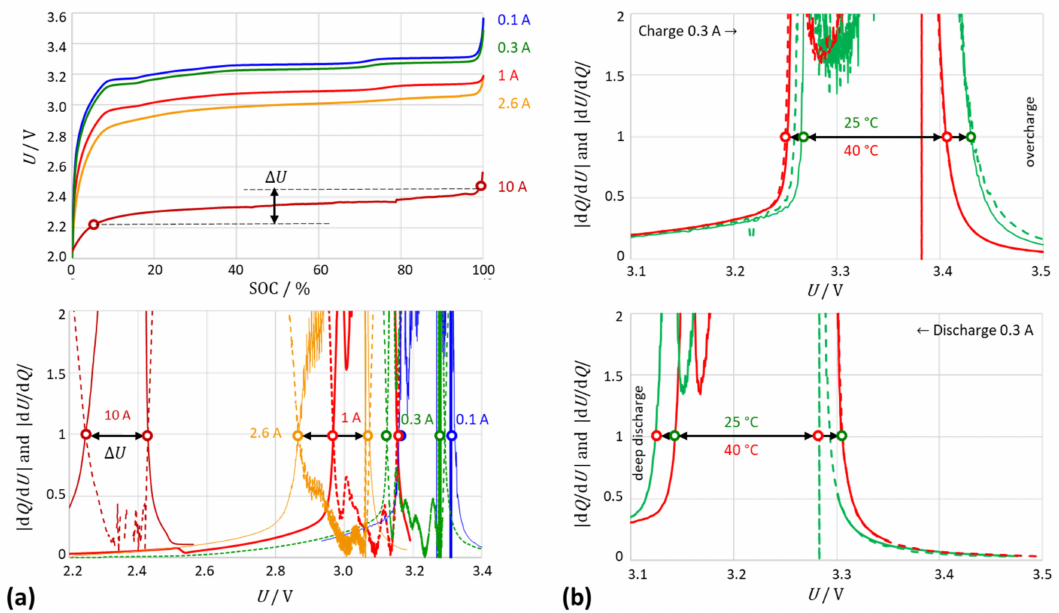
Figure 6. Application of the intersection method to measurements on a lithium iron phosphate battery: ( a ) Variation of current: discharge characteristics (above) and change of voltage window based on differential capacity and its reciprocal (below). ∆ U is the ‘safe’ voltage window and a measure of the battery’s internal resistance. ( b ) Variation of temperature during charging ( above ) and discharging ( below ) the battery. The scatter at small currents is a consequence of the used measurement